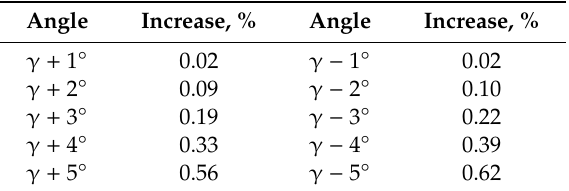
Table 1. Increase in Stator Current due to Angle Variation.